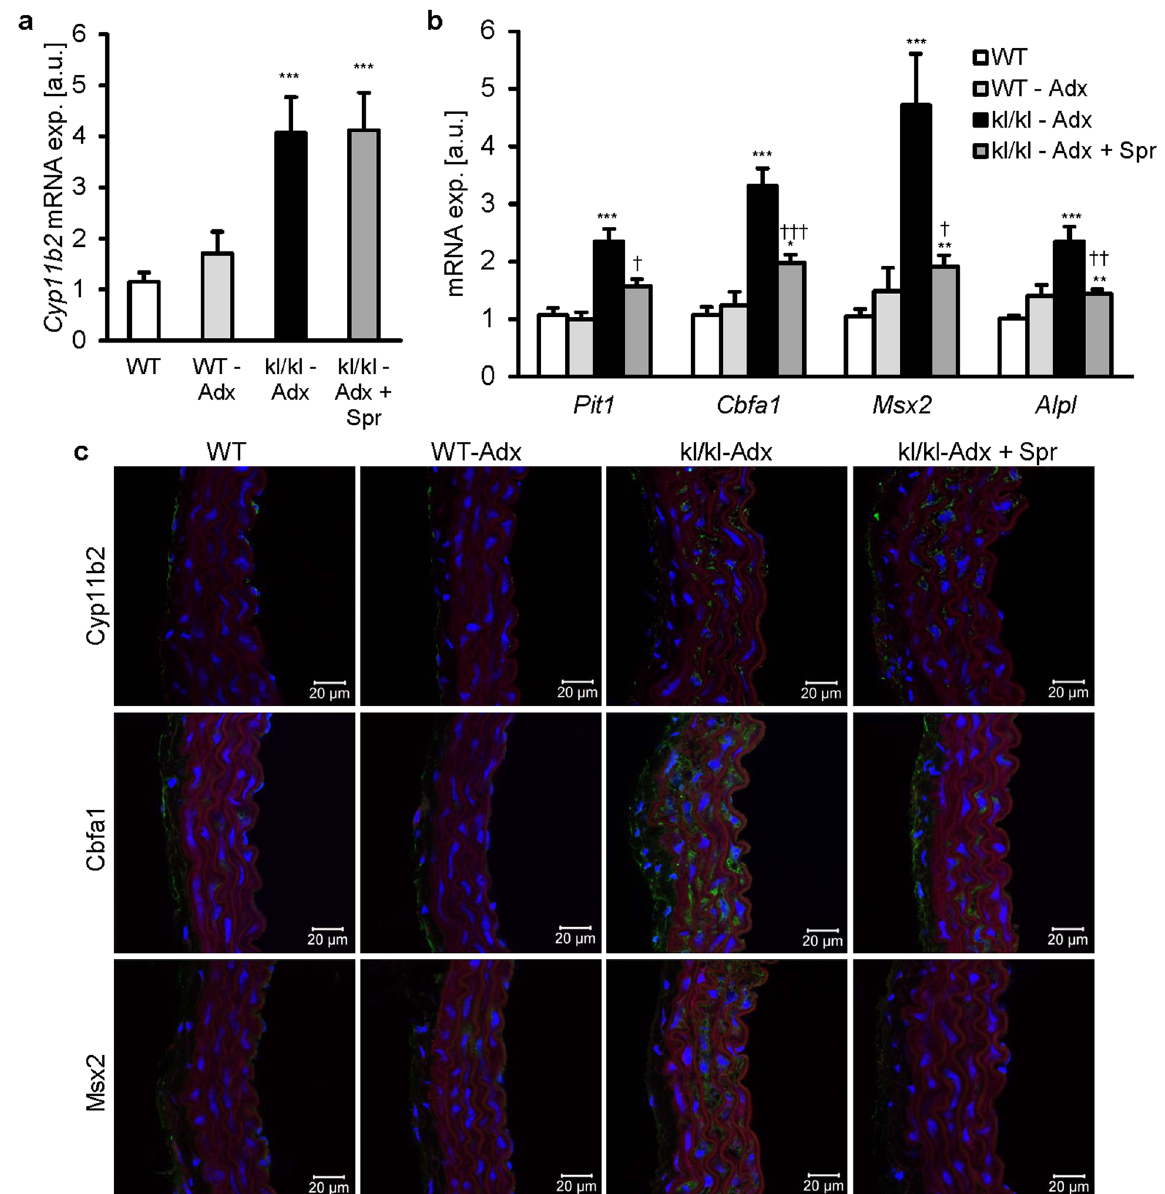
Figure 7. Vascular osteoinductive transformation in adrenalectomized kl/kl mice is ameliorated by spironolactone. Arithmetic means ± SEM (n = 10–11; arbitrary units, a.u) of aortic Cyp11b2 ( a ) and Pit1 , Cbfa1, Msx2 and Alpl ( b ) relative mRNA expression in wild-type (WT) and kl/kl mice following discontinuation of dietary rescue and treatment without or with spironolactone (Spr) and adrenalectomy (Adx) for 5 weeks. * (p < 0.05), ** (p < 0.01), *** (p < 0.001) statistically significant vs. WT control mice. † (p < 0.05), †† (p < 0.01) statistically significant between kl/kl- Adx and kl/kl -Adx + Spr. ( c ) Representative confocal microscopy images showing Cyp11b2, Cbfa1 and Msx2 protein expression in aortic tissues from wild-type (WT) and kl/ kl mice following discontinuation of dietary rescue and treatment without or with spironolactone (Spr) and adrenalectomy (Adx) for 5 weeks. Images are representative of four mice per group. Protein expression: green labeling; nuclei: blue labeling and actin staining: red labeling. Scale bar: 20 µ